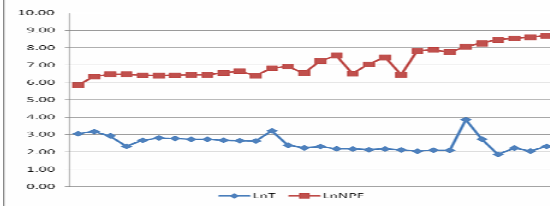
Figure-02: Non-Performing Financing and